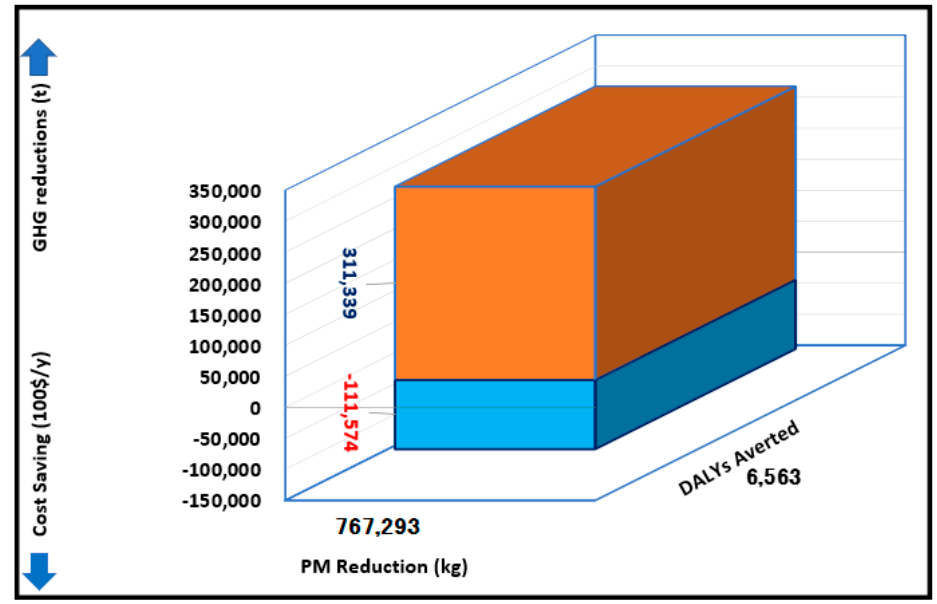
Figure 10. Combined co-benefits from the intervention of the combined scenario (Estimated by the authors).